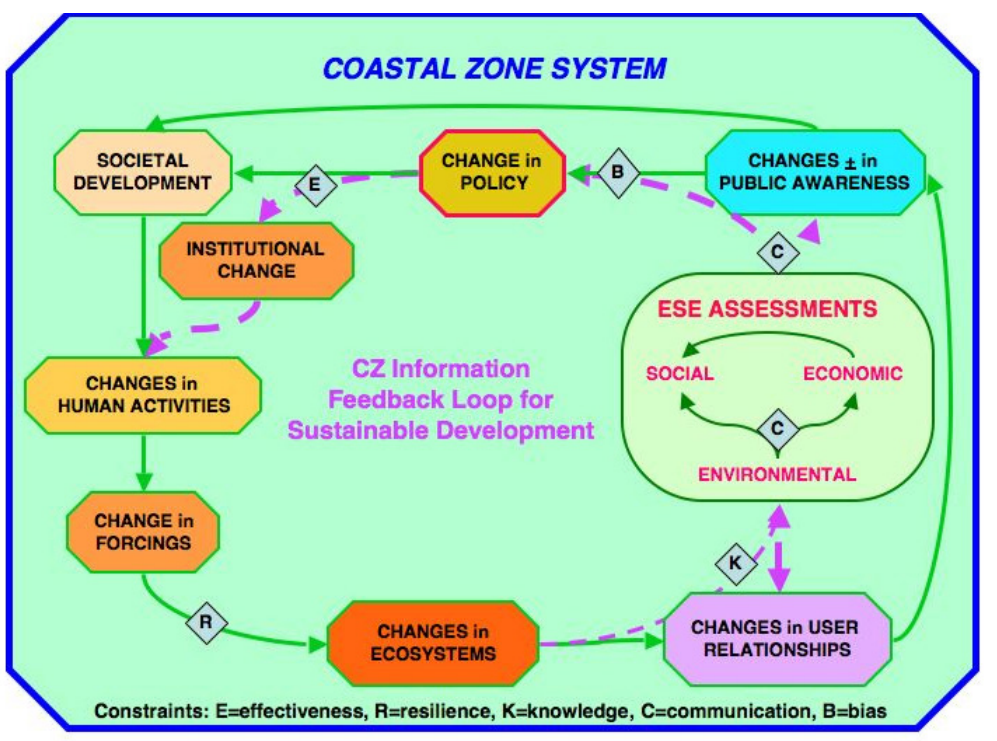
Fig. 2 . Coastal Zone System Information Feedback Loops